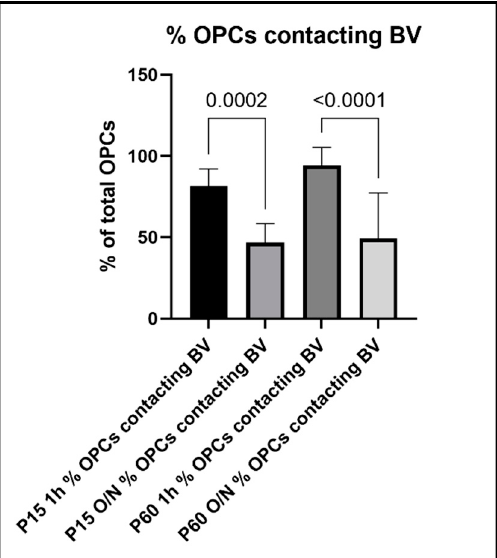
Figure 7. Percentage of OPCs that established contact to blood vessels in the different experi- mental groups.